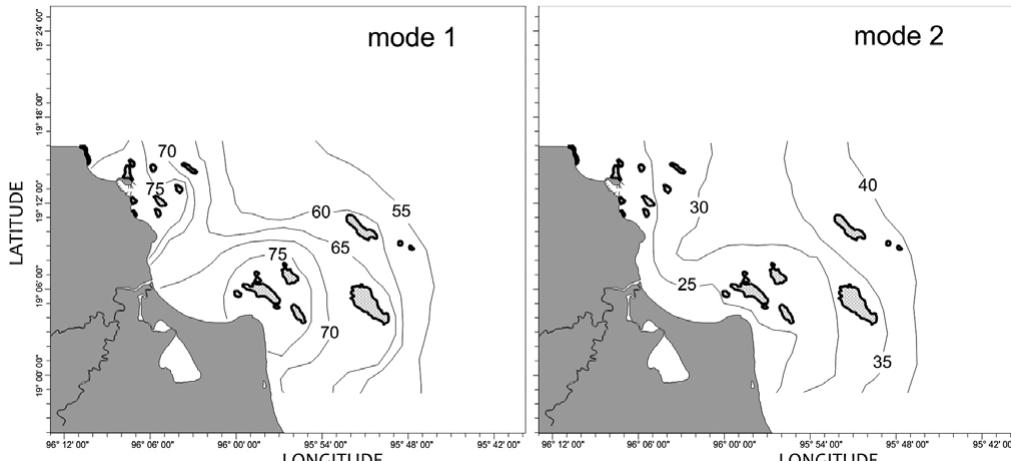
Fig. 8. – Mode 1 and 2 of the empirical orthogonal functions (EOF) of the water speed as calculated from the monthly yearlong data set from January to November